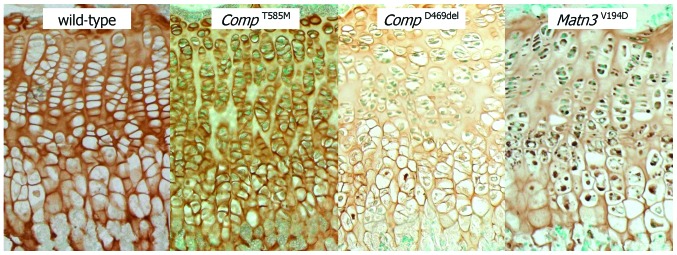
Organization of the growth plate in mutant mice is disrupted by 3 weeks of age and shows marked hypocellularity along with the retention and/or mislocalisation of cartilage structural proteins. Representative immunohistochemistry (IHC) of the growth plates from 3 week-old wild-type and mutant mice showing disruption to chondrocyte columns in mice homozygous for the Comp p.Thr585Met (CompT585M), Comp p.D469del (CompD469del) and Matn3 Val194Asp (Matn3V194D) mutations. IHC using COMP (wild-type, CompT585M and CompD469del) and matrilin-3 (Matn3V194D) antibodies revealed less staining in the extracellular matrix (ECM) between the proliferating columns in the growth plates of mice carrying all three mutations. Furthermore, there was intracellular staining for mutant COMP and matrilin-3 in chondrocytes from the CompD469del and Matn3V194D mice, respectively.